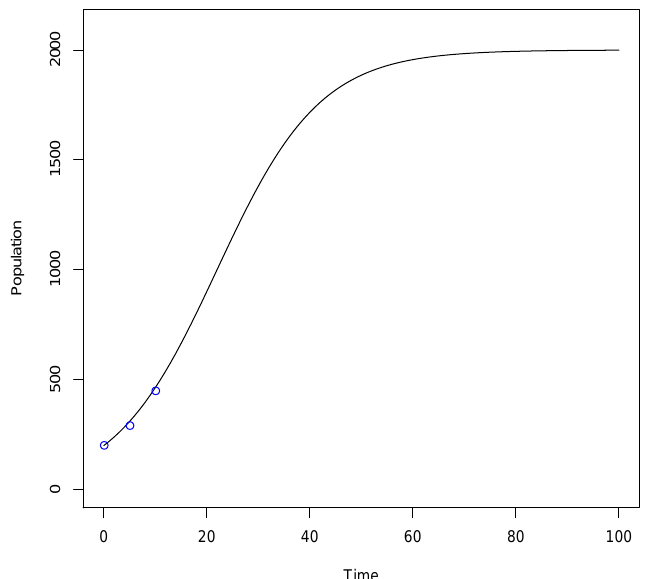
Figure 1. An initial design of three points is plotted in blue. The ground truth model of normal 10% growth is plotted as a black curve across one hundred time points with a carrying capacity of two thousand and initial population of two hundred.